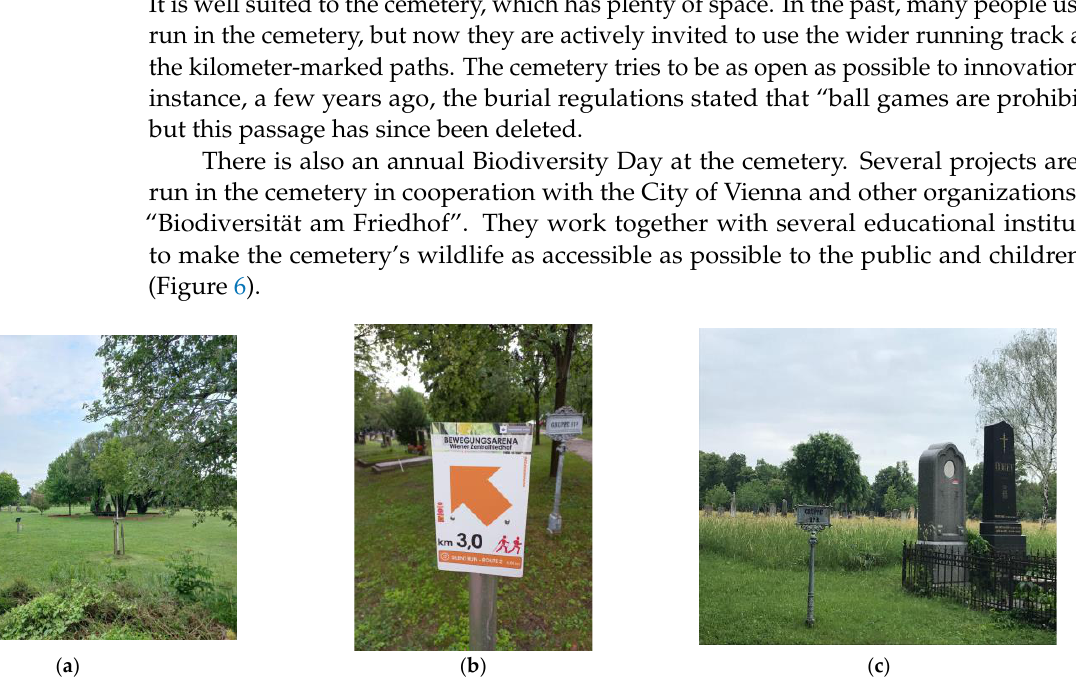
Figure 6. Zentralfriedhof Wien: ( a ) Park der Ruhe und Kraft/Park of peace and strength, ( b ) running route kilometer board, ( c ) bee pasture (authors ’ photos, 2022).